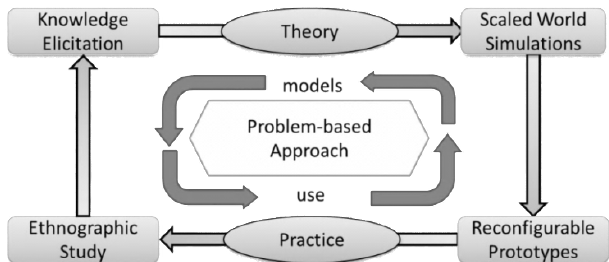
Figure 1 The Living Lab Framework (McNeese,